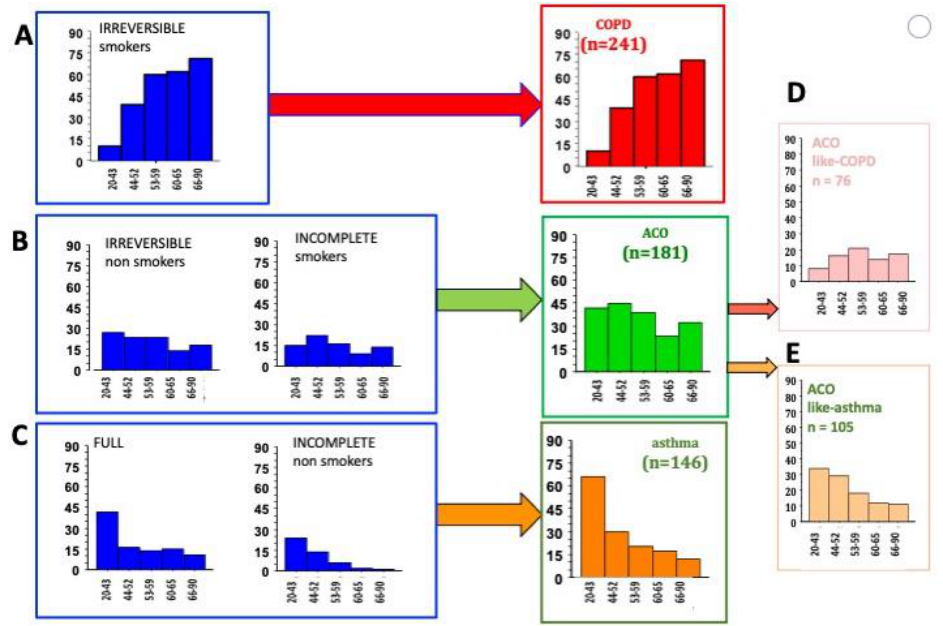
Figure 3. The relationship between the age groups and the prevalence of each phenotype of obstruc- tive airway diseases. Patients were defined as ( A ) COPD, ( C ) asthma or ( B ) ACO in regard to a positive, negative or non-significant relationship with aging. ( D ): the age-related relative prevalence of ACO-like COPD (pink bar) with a DLCO < 80% PV. ( E ): the age-related relative prevalence of ACO-like asthma (light orange bar) with a DLCO ≥ 80% PV. COPD: chronic obstructive pulmonary disease. ACO: asthma—COPD overlap. Table 1. Characteristics of asthma, ACO and COPD (N = 568) [n